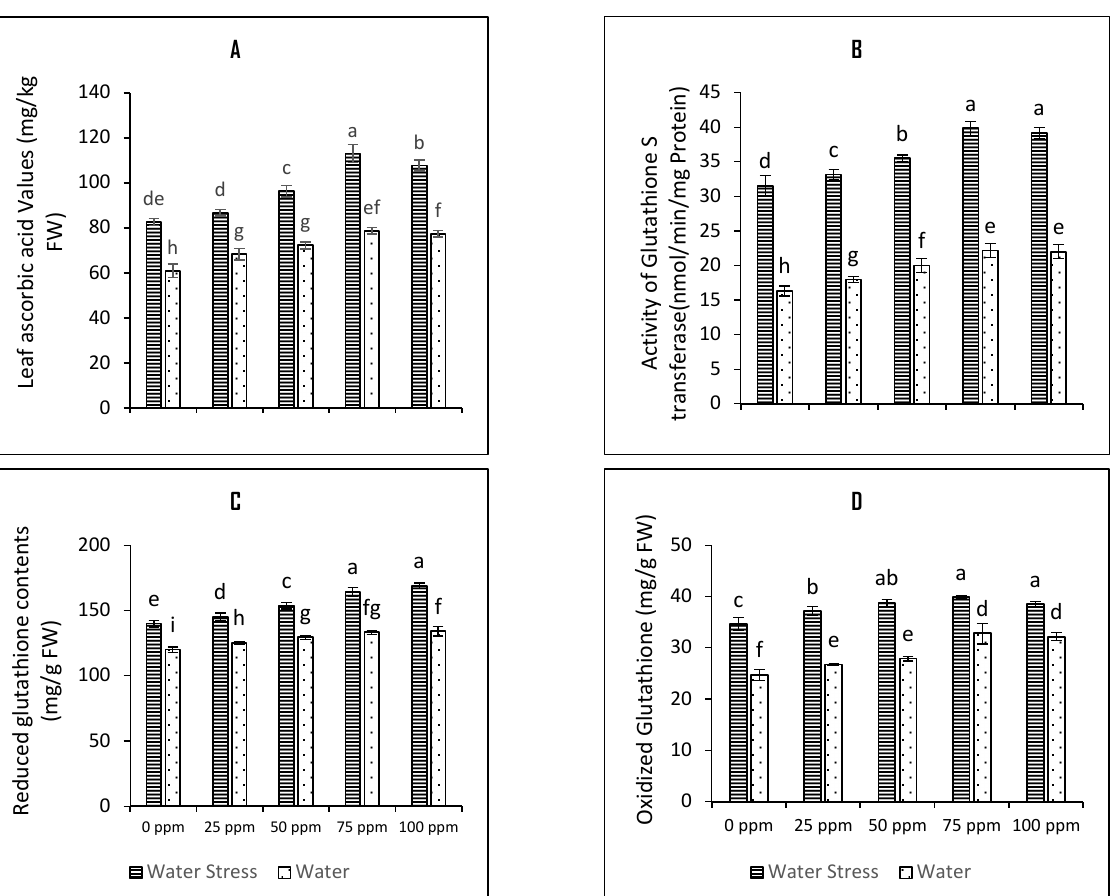
Figure 4. Bar charts (mean ± S.E; n = 3) representing activity of glutathione s transferase, and contents of ascorbic acid and glutathione in tomato plants raised from SeNPs-primed seeds grown under water stress and water conditions where: ( A ) leaf ascorbic acid contents ( B ) glutathione s transferase activity ( C ) reduced glutathione contents and ( D ) oxidized glutathione. 0, 25, 50, 75, and 100 ppm on x -axis represent concentrations of Se-NPs followed in the seed priming experiment. Bars with di ff erent alphabets represents mean data which signi fi cantly di ff ers at ( p < 0.05).